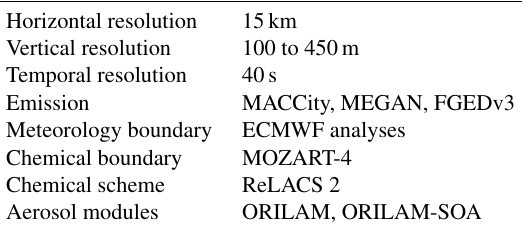
Table 2. Model setup